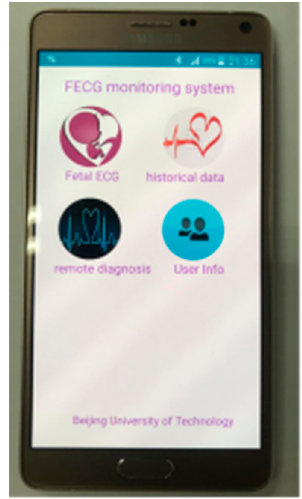
Figure 7. Android phone client main interface.